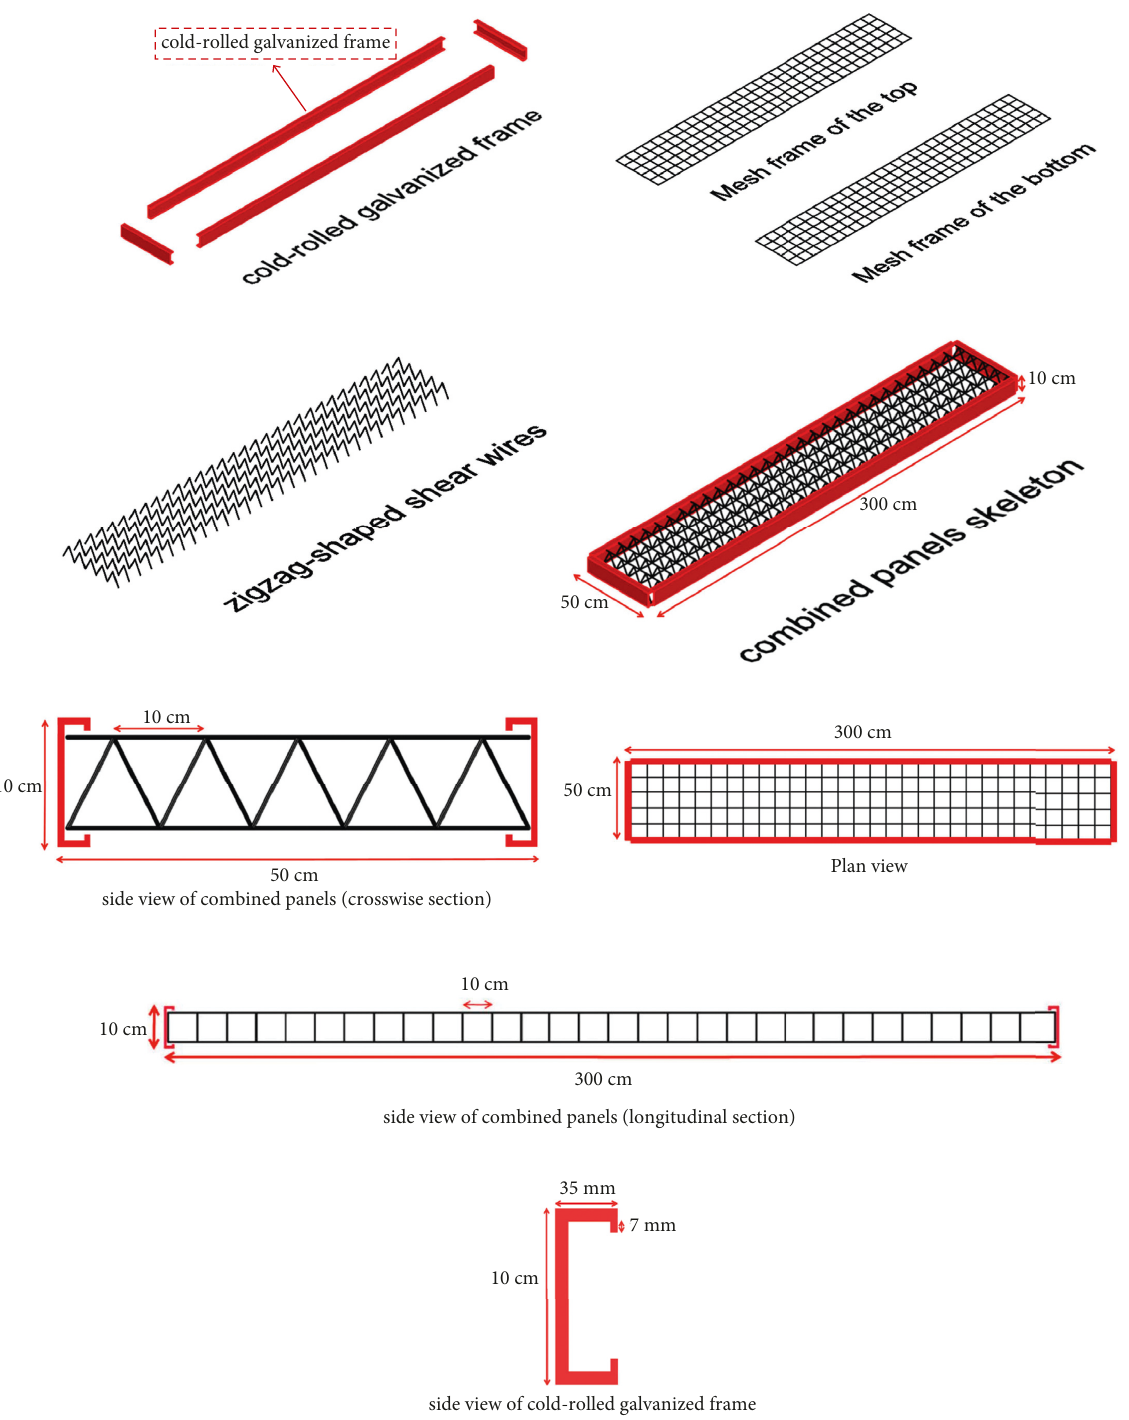
Figure 1: The plan and the cross-sectional view of the combined composite panels filled with foamed concrete or fire-resistance poly- urethane